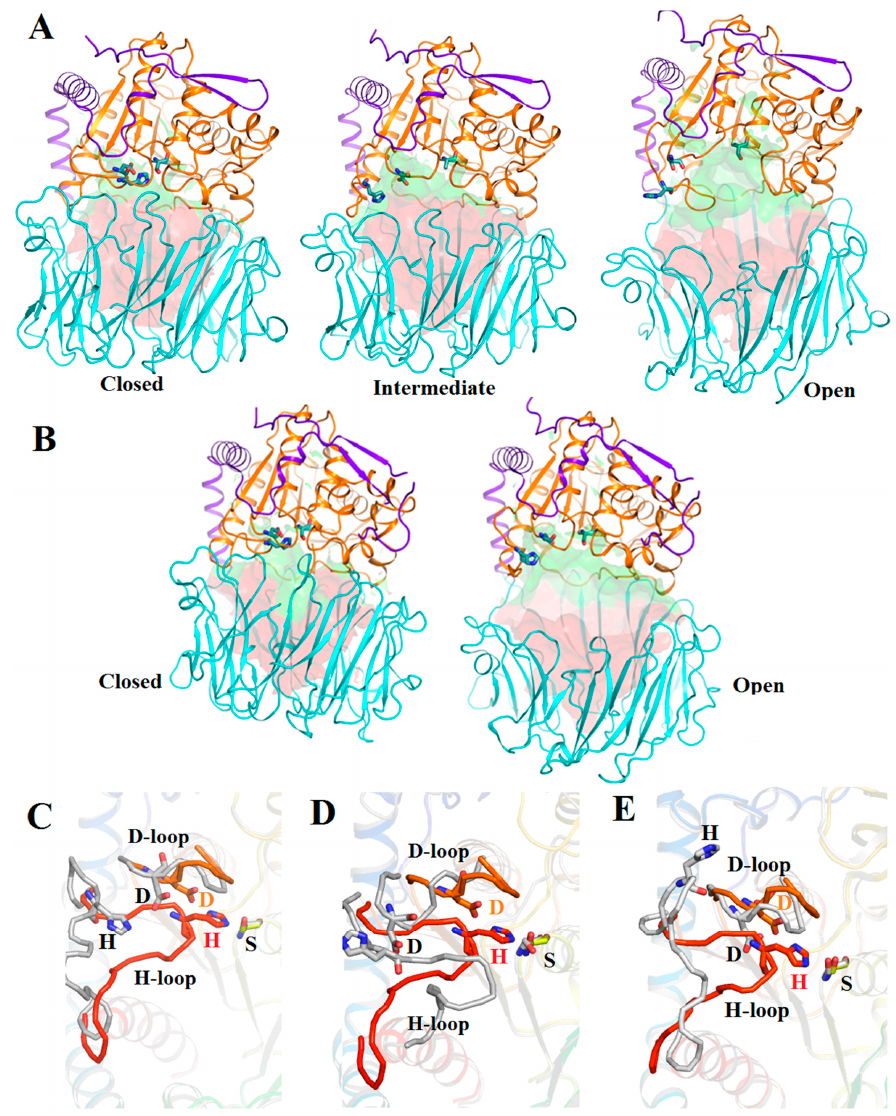
Figure 4. Visualization of the main structural characteristics of SpOpB and TbOpB in various conformations. ( A ) Cartoon/surface presentations of the structures of SpOpB-TCK in the closed state (PDB ID 7YWP), SpOpB_S532A in the intermediate state (PDB ID 7ZJZ), and SAXS-validated model of SpOpB in the open state. The N-terminal loops of the catalytic domains are in violet, the β -propeller domains are in cyan, and the α / β -hydrolase folds are in orange. The catalytic triad residues are shown in emerald sticks; the inhibitor molecule in the 7YWP structure is omitted. The solution accessible areas in the funnel-like β -propeller tunnel and interdomain cavity are colored in red and green, respectively. ( B ) Similar presentations of the TbOpB structures in the closed and open states (PDB ID 4BP9 and 4BP8, respectively). ( C , D ) The assembled catalytic triad in the SpOpB closed state (rainbow coloring) superimposed on the disrupted catalytic triad (colored in grey) in the intermediate ( C ) and open ( D ) conformations of SpOpB. The catalytic residues are shown as sticks and named; the covalently bound inhibitor is omitted. ( E ) Similar superposition of the assembled and dissembled catalytic triad in the closed and open state of